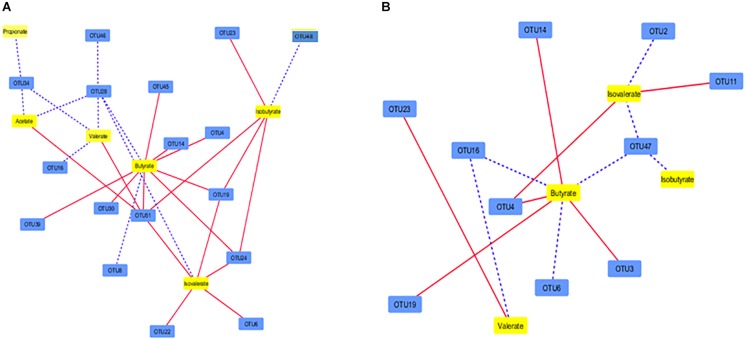
Correlation network showing the correlation between SCFAs in the ruminal fluid and the major OTUs (each representing ≥0.1% total sequences) in the solid (A) and liquid fractions of digesta (B). Dotted lines indicate positive correlations whereas solid lines represent negative correlations. The shorter the distances between two nodes, the stronger the correlation between them. See Supplementary Table S5 for the taxonomic assignment of the OTUs.